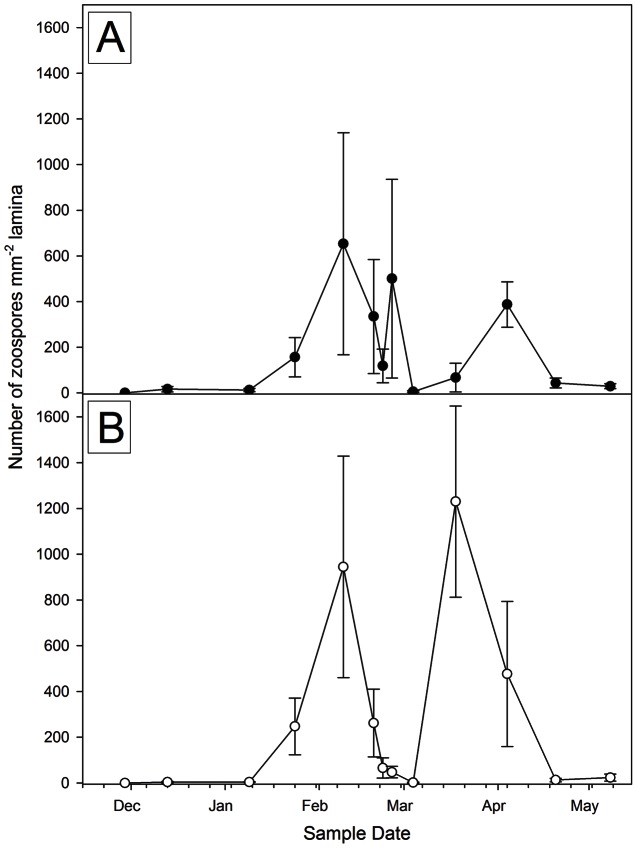
Mean (±SE) number of zoospores in Ecklonia radiata plants measured at two-weekly intervals for five months.Number of zoospores measured per mm of lamina tissue, five month sampling period from November 2010 to May 2011. Two sites were Barrel Site (Plot A; black, solid circles) and Haliotis Bay North (Plot B; white, hollow circles).